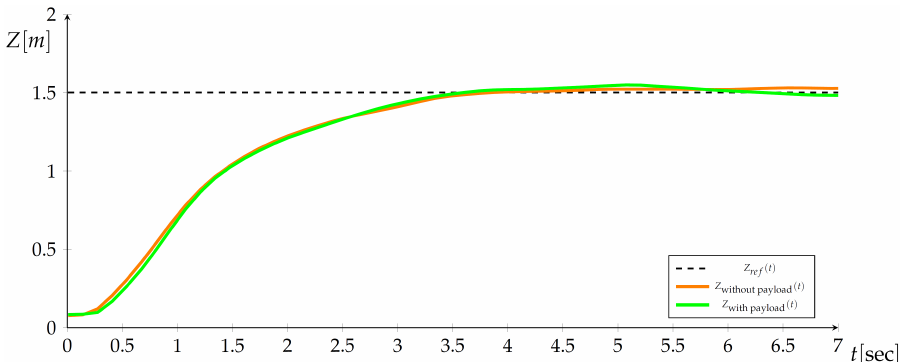
Figure 18. The Bebop 2 with additional payload used for in-flight auto-tuning experiments.